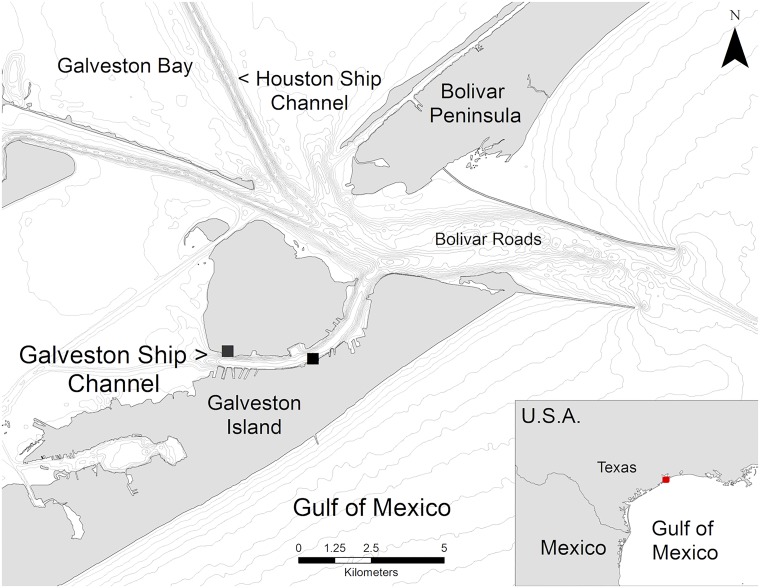
Study area showing theodolite observation platforms (■) and isobaths at 5m intervals.Map created using ArcGIS software from Environmental Systems Research Institute (ESRI) and shapefiles from Texas Natural Resources Information System (Public Domain–Creative Commons CCO).